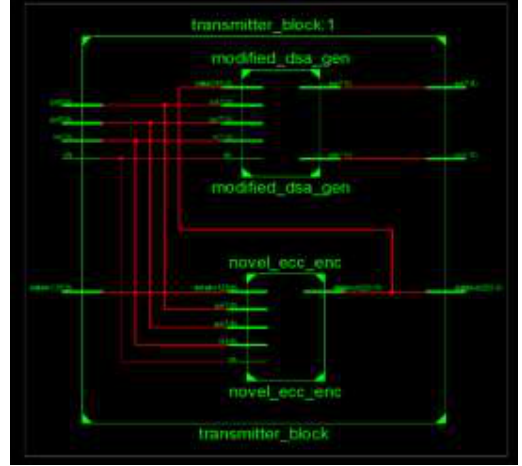
Figure 8. Block Diagram of Cryptoprocessor